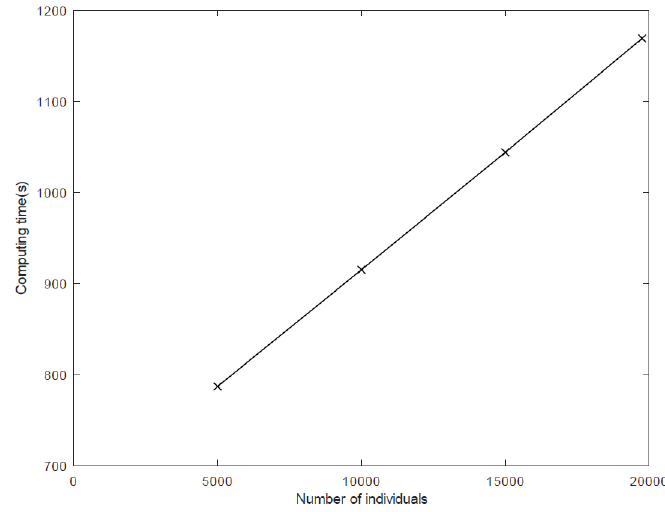
Fig. 1. Computing time (in seconds) for 46914 SNP markers and an increasing number of individuals from 5000 to 19757